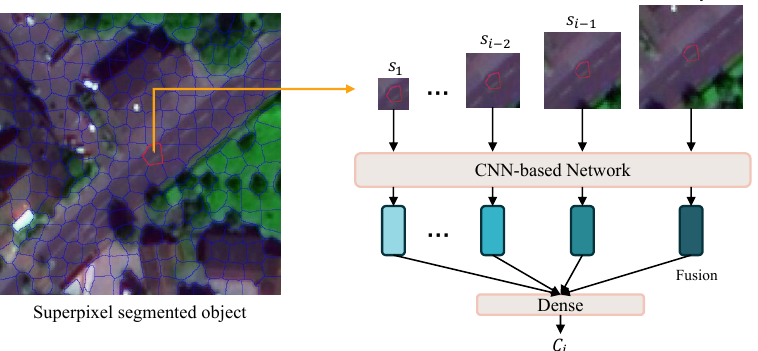
Figure 1. Illustration of a superpixel segmented object by multi-scale input to deep neural networks for classification, where C i denotes the class of a superpixel